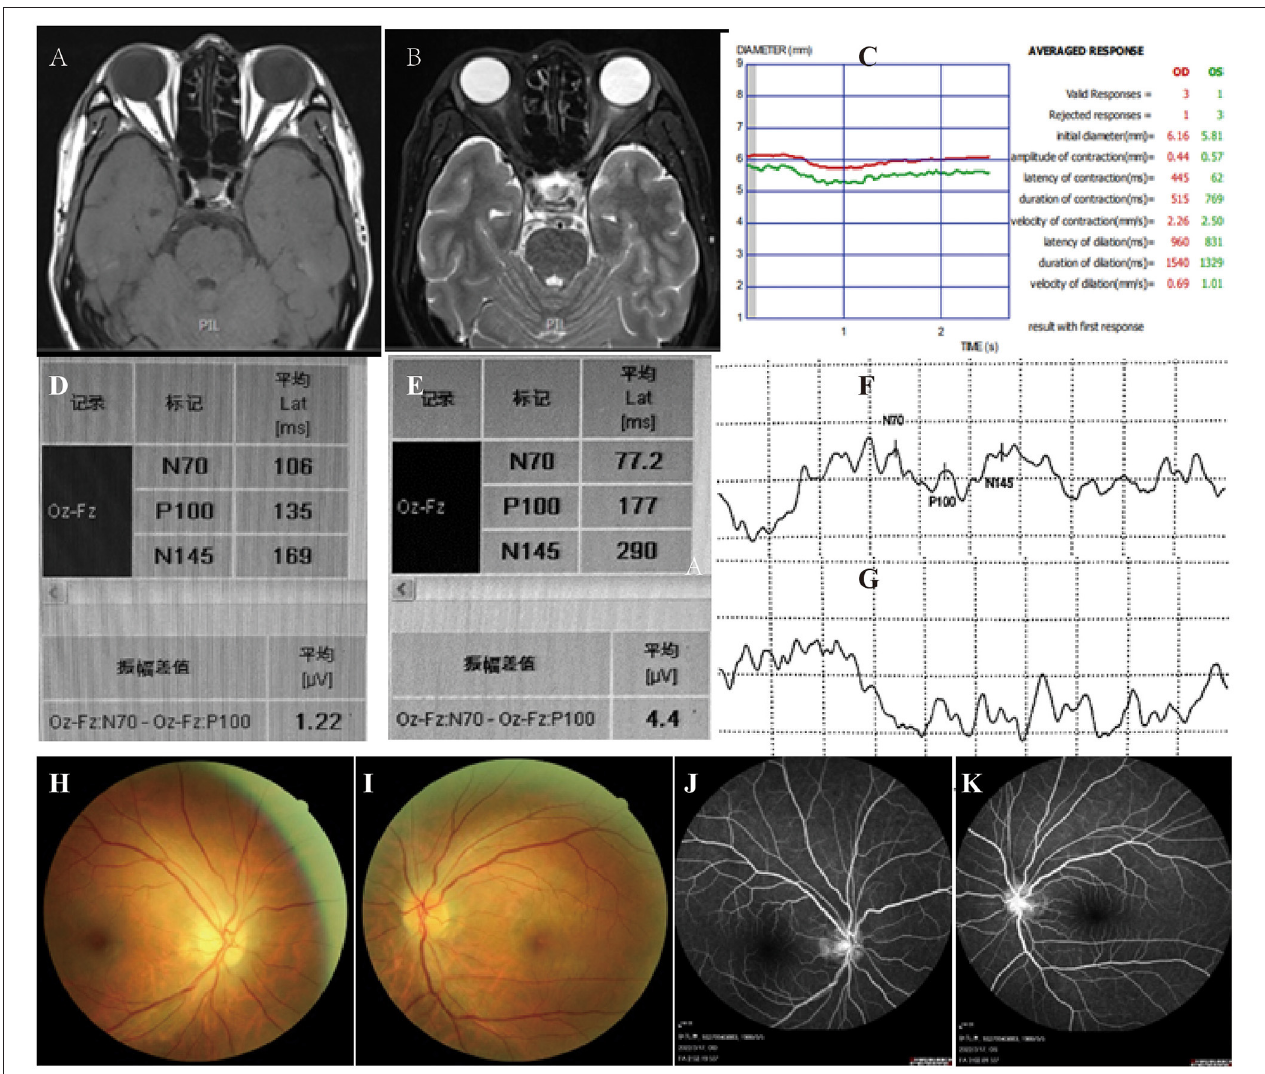
FIGURE 2 | Optic nerve MRIs: T1 (A) and T2 (B) showed increased signal of bilateral optic nerve, especially the left one with thickening. (C) Pupillary light reflex showed both eyes are insensitive to light. Visual evoked potentials demonstrated prolonged latent time of P100 and decreased amplitude of wave in the right eye (D,F) , and no clear waveforms of P100 were elicited in the left (E,G) . Fundus examination revealed bilateral optic disc swelling (H,I) , especially the right one (H) . Fundus fluorescein angiography demonstrated no fluorescein leakage (J) and (K) for left and right